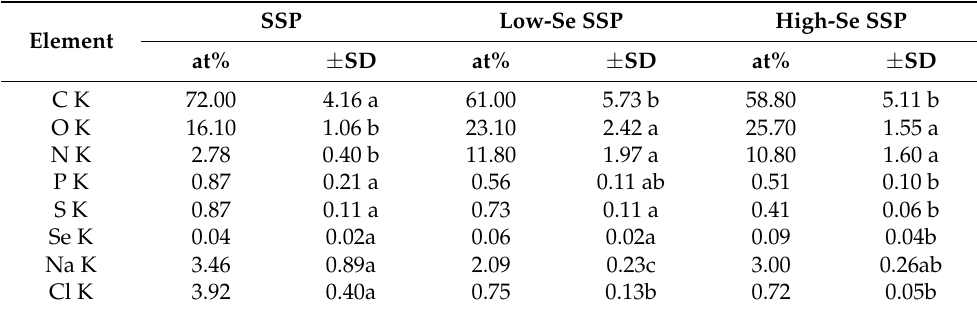
Table 2. Weight and atomic percentages of elements in SSP, low-Se SSP, and high-Se SSP as determined by SEM-EDS.